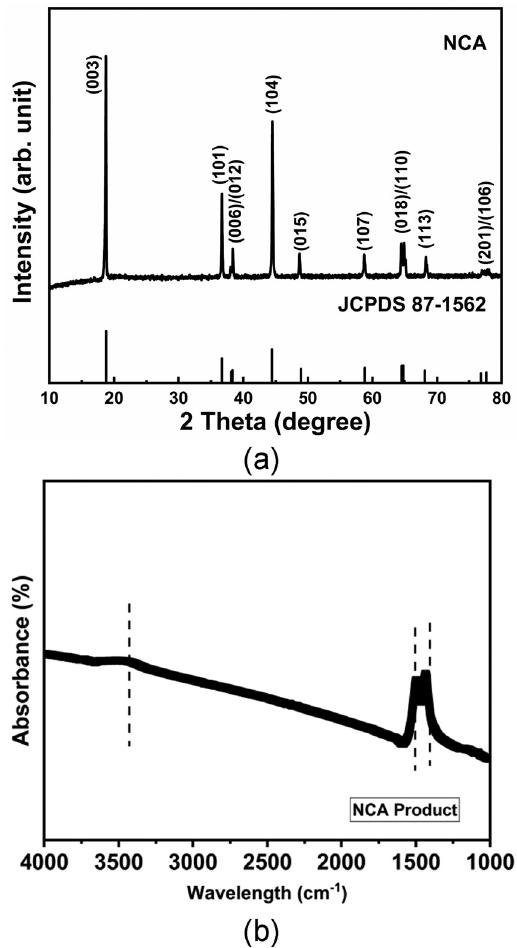
Figure 3: ( a ) X - ray di ff ractogram and ( b ) modi fi ed FTIR spectra of as - prepared NCA powder.